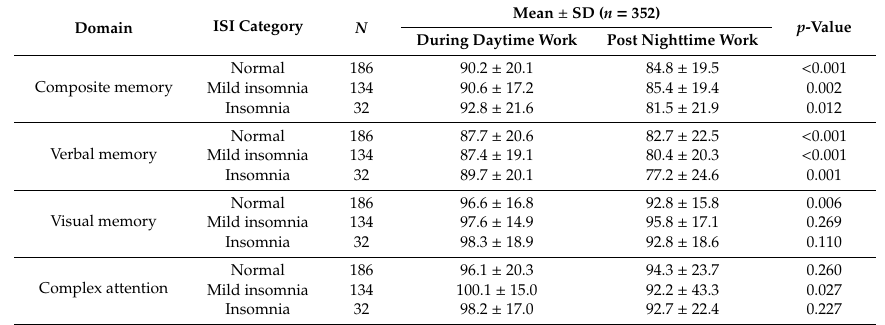
Table 3. Comparison of the neurocognitive function during the daytime work and after the night shift work of firefighters according to the Insomnia Severity Index (ISI)